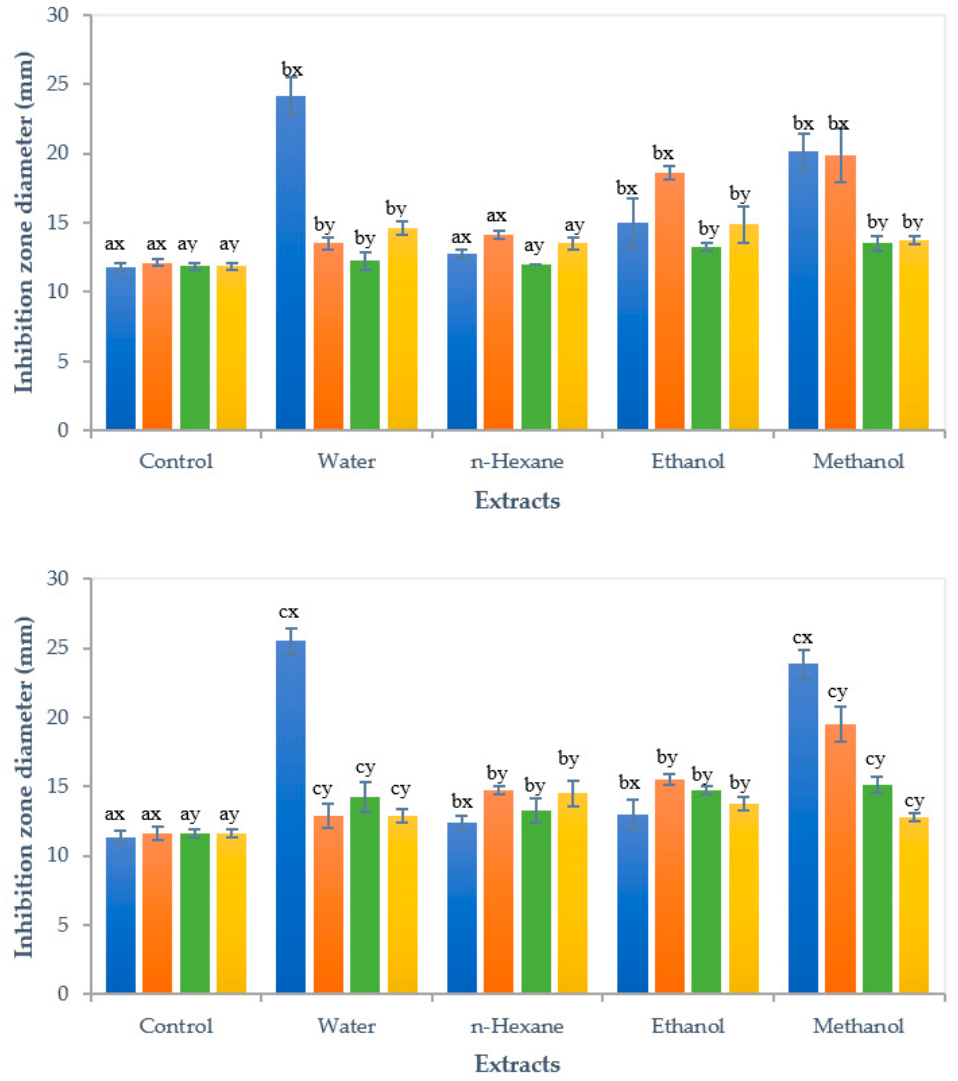
Figure 3. Antibacterial activity of peel (top) and pulp (bottom) extracts of red tamarillo. Data are presented as mean (mm) and standard deviation in error bar ( n = 3). Different letters indicate statistical difference ( P < 0.05) using Two-way ANOVA. Means shown in a, b, c are significantly different at P < 0.05 between solvent extracts. Means shown in x and y are significantly different at P < 0.05 between bacteria. ( Escherichia coli , Pseudomonas aeruginosa , Staphylococcus aureus , Streptococcus pyogenes ). Control was water without any tamarillo extract.